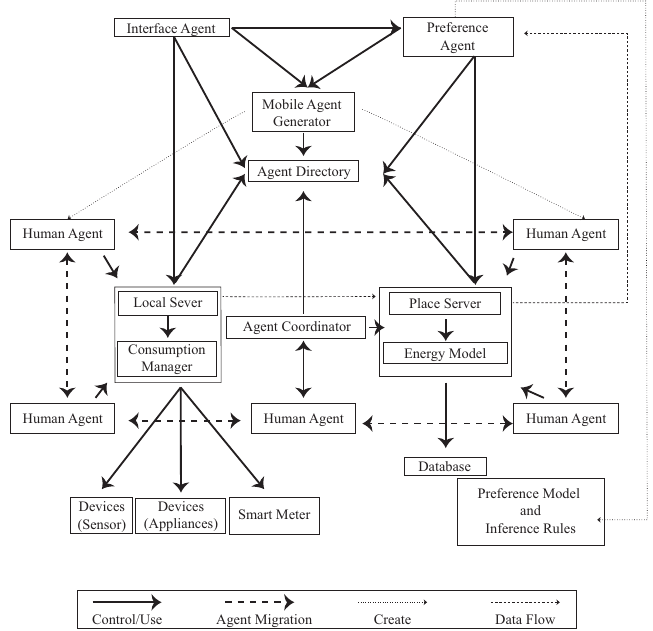
Figure 1. The concept of the user behavior dataflow in the SENS virtual environment